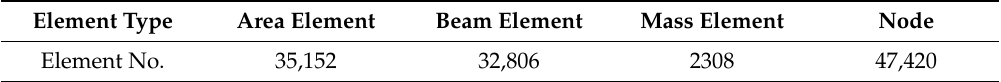
Table 1. Element type and element